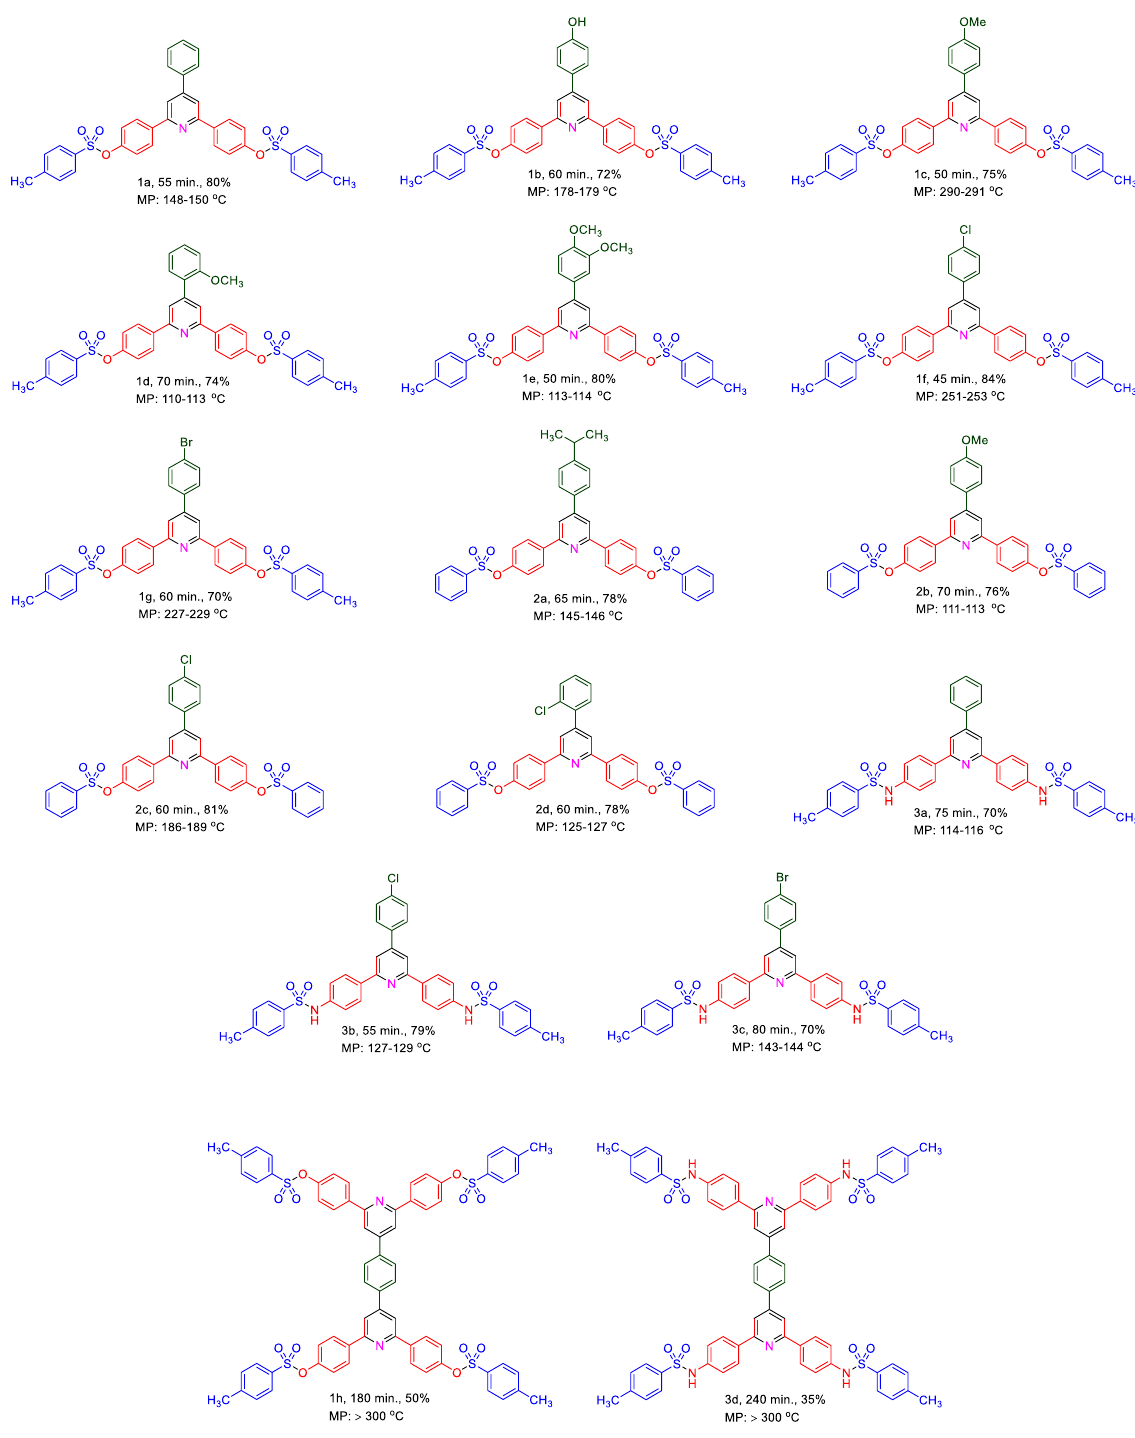
Table 3. Synthesis a new library of triarylpyridine derivatives bearing sulfonate and sulfonamide moieties in the presence of